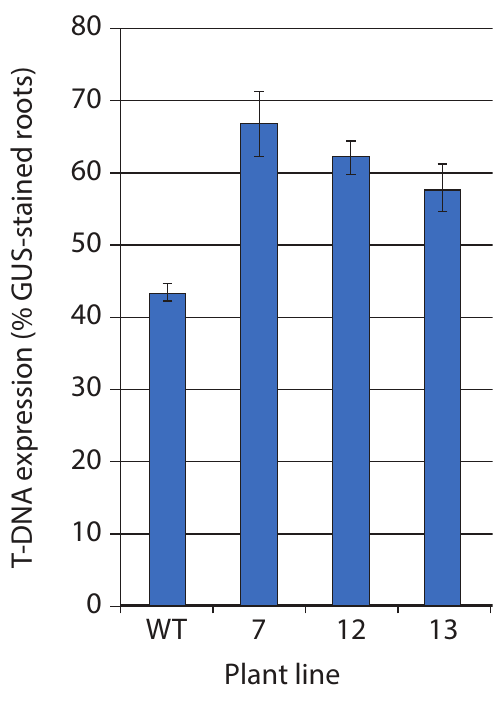
Figure 2. The effect of WRKY17 mutation on susceptibility of Arabidopsis roots to Agrobacterium infection . Transformation efficiency is expressed as the percent of β -glucuronidase (GUS)- stained roots from the total number of roots tested. All data represent average values of three independent experiments with indicated standard deviations. WT, wild-type plants; 7, 12, and 13 are the three different lines of the homozygous wrky17-1